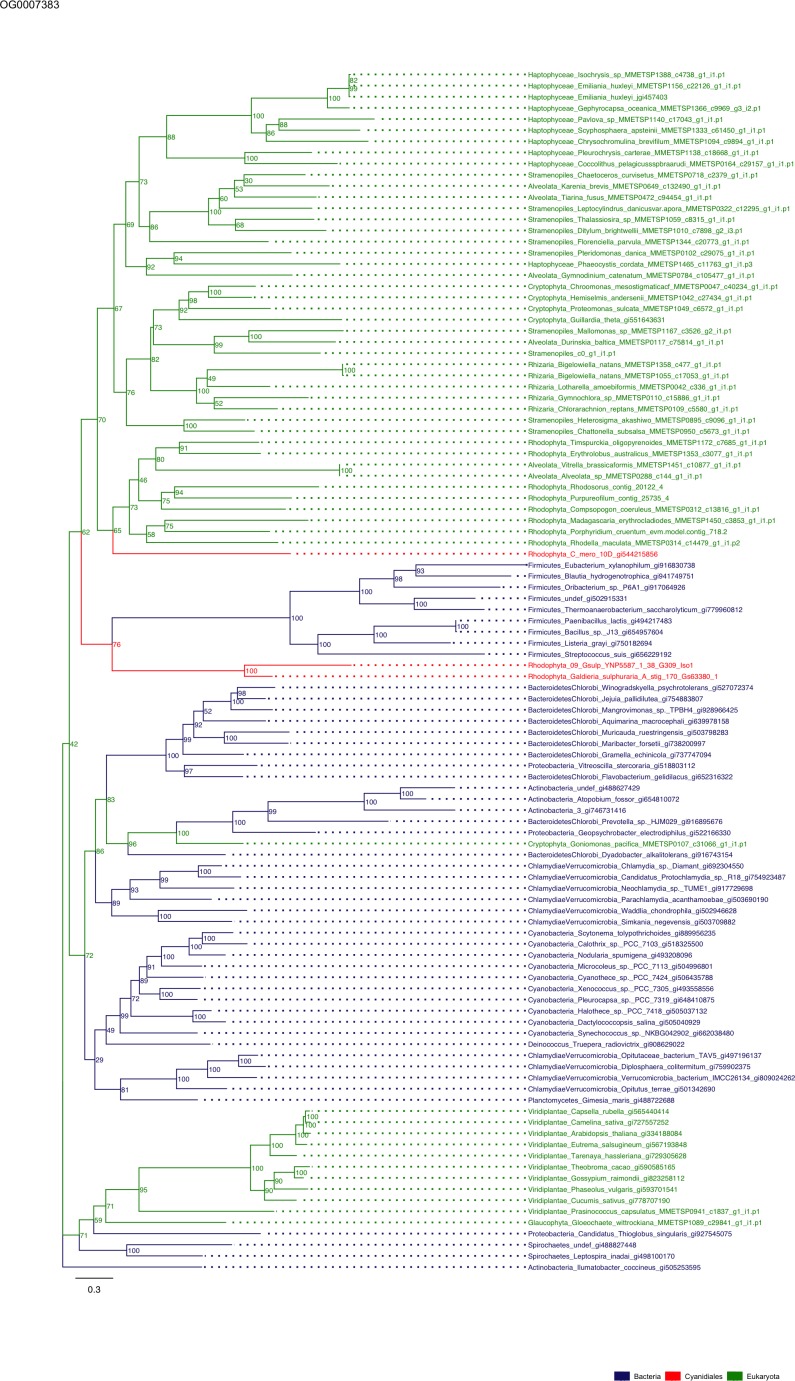
Sequence tree of orthogroup OG0007383.The tree is based on amino acid sequences. Archaea (yellow), Bacteria (blue), Cyanidiales (red), Eukaryotes including other red algae (green). Branches containing Cyanidiales sequences are highlited in red.